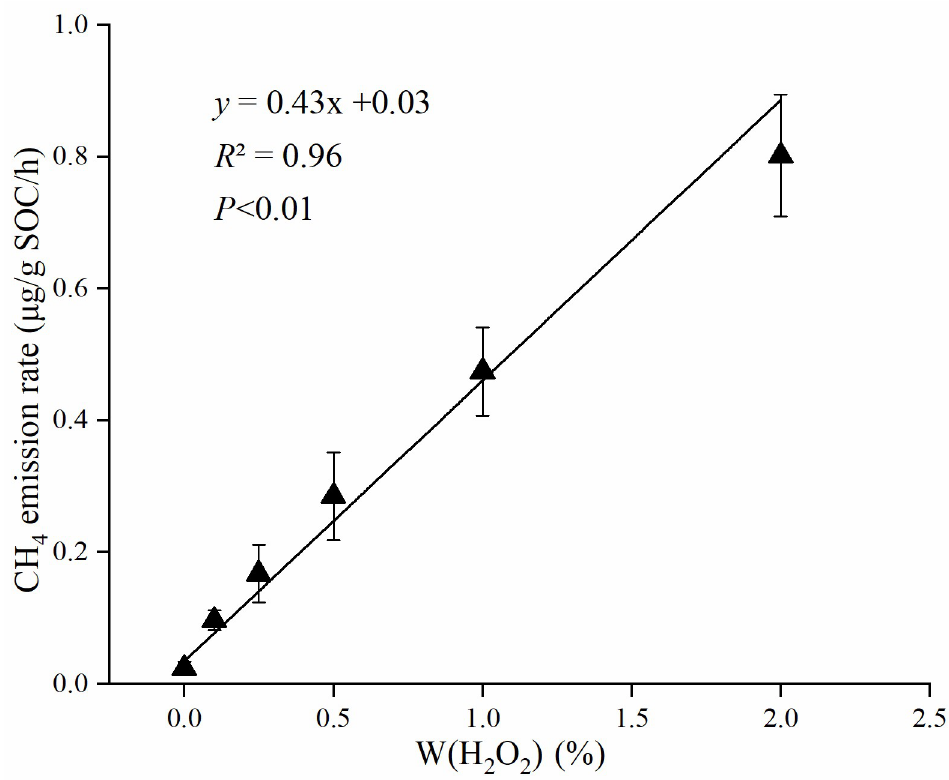
Fig 4. The emission rates of NM-CH 4 at different concentrations of H 2 O 2 (0, 0.1%, 0.25%, 0.5%, 1%, 2%) in aerobic environment at 30 ˚C.